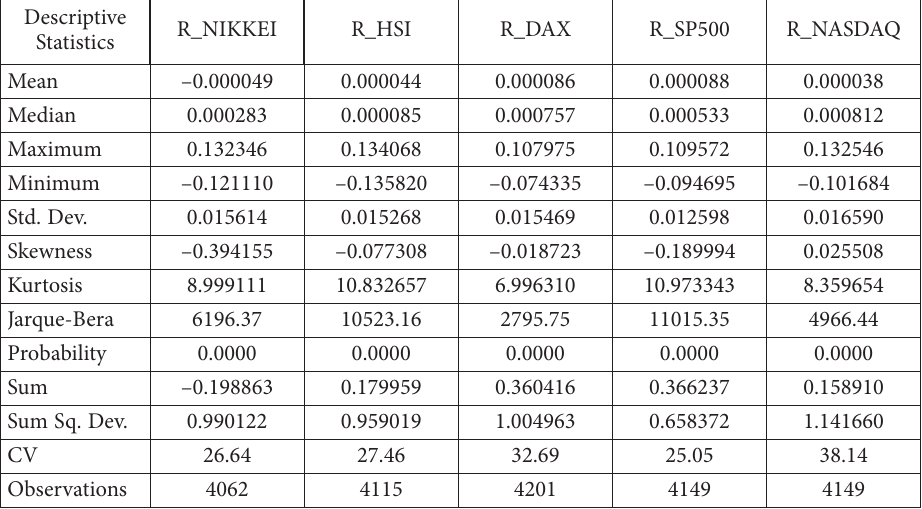
Table 2. Descriptive statistics for developed stock